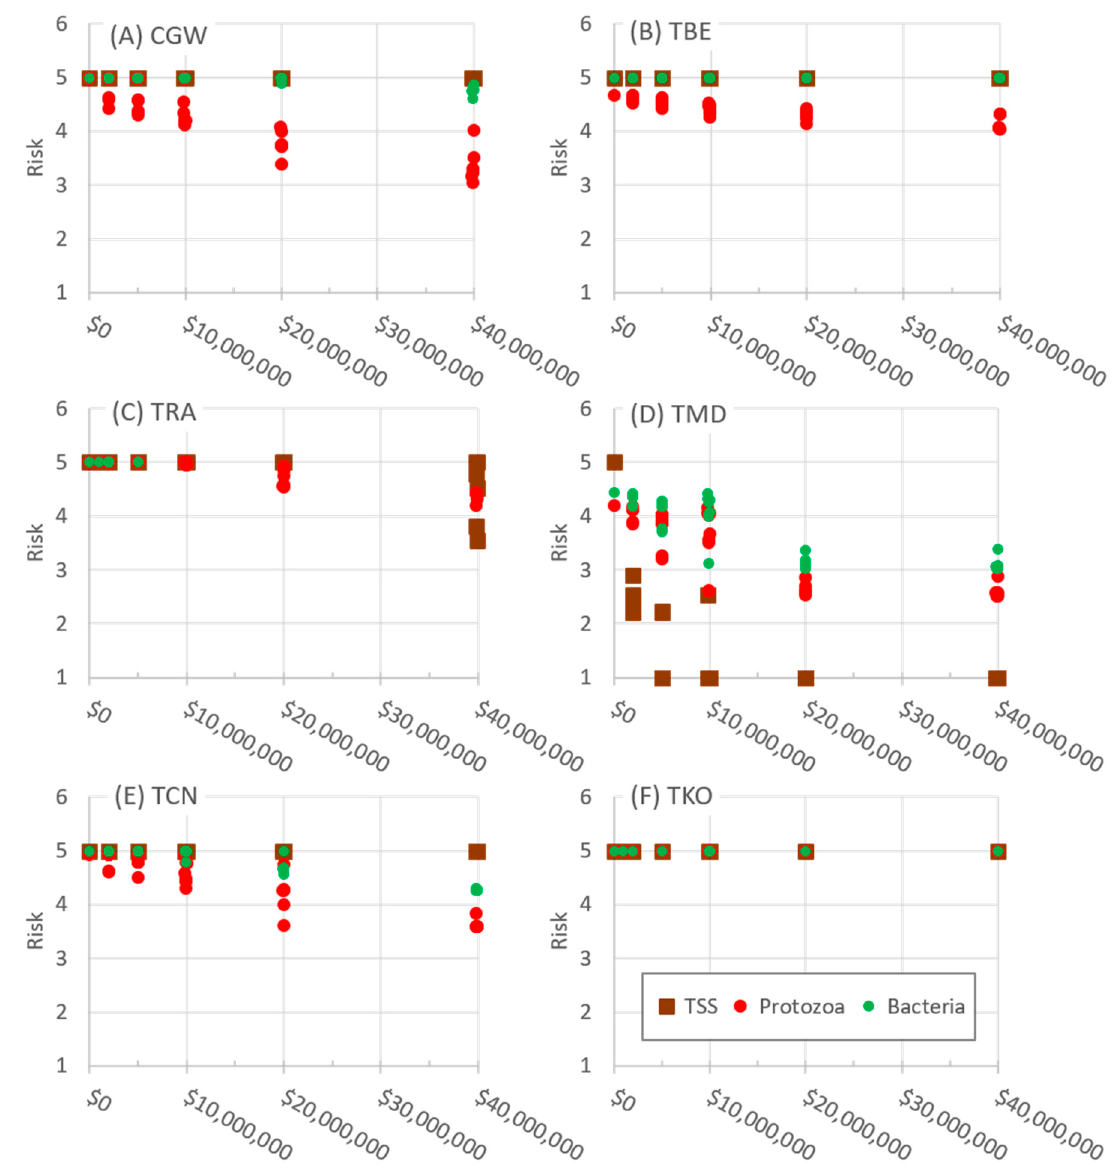
Figure 4. Variation in drinking water quality risk for each hazard (TSS, protozoa and bacteria) at each WTP based on 35 optimization simulations across budgets of $2M, $5M, $10M, $20M and $40M. Risk level 1 to 5 represents Insignificant, Low, Moderate, High and Very-high risk, respectively.